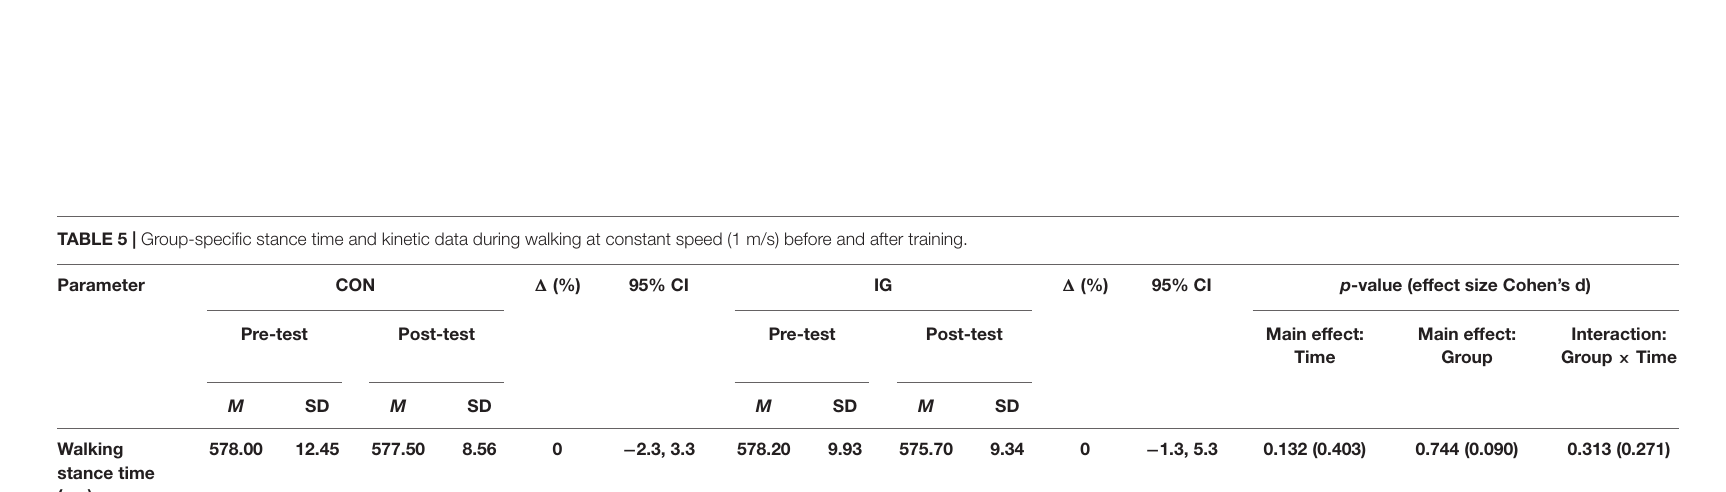
Walking stance time